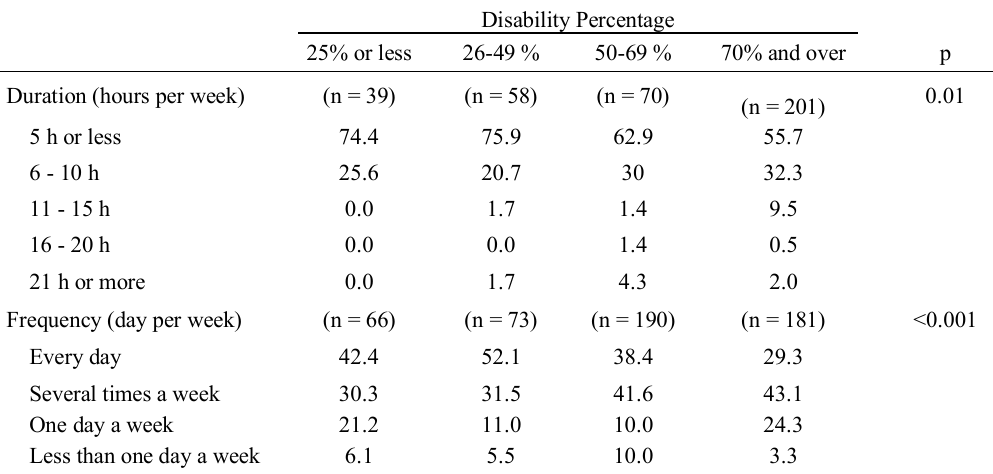
Table 3. Duration and frequency of participation in sports and physical activity according to Disability Percentage” and result of Fisher's exact test.